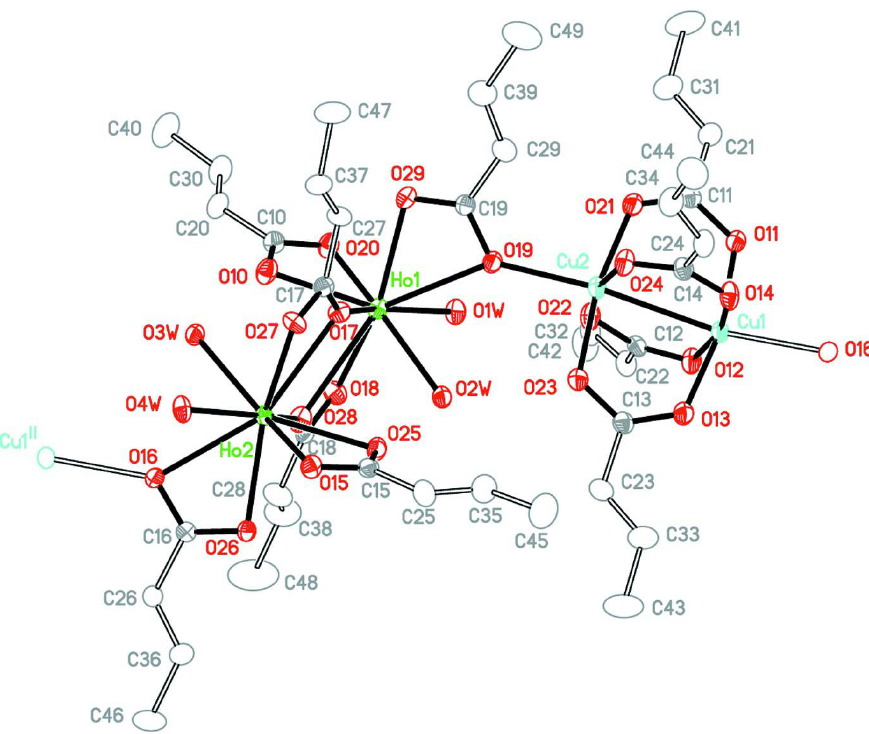
Figure 1 Molecular view of both dimers, with displacement ellipsoids at a 30% level. H atoms omitted, and carbon atoms not in the carboxylate groups drawn in empty ellipsoids and bonds, for